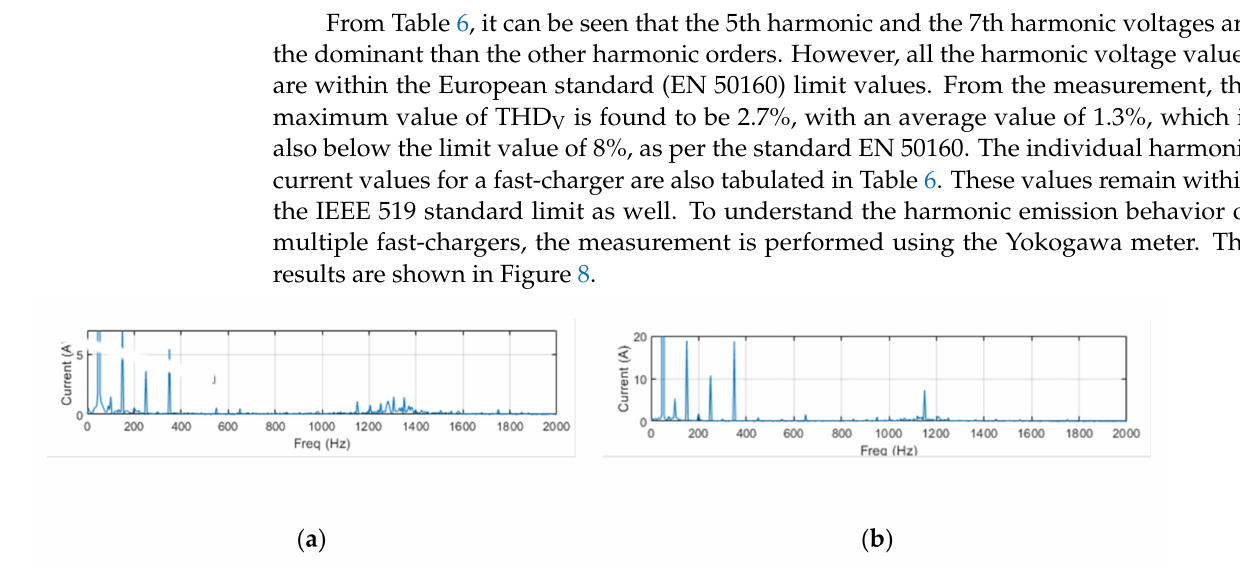
Figure 8. Harmonic current measurements at fast-charger terminals of the installation. ( a ) One fast-charger active; and ( b ) Four fast-chargers